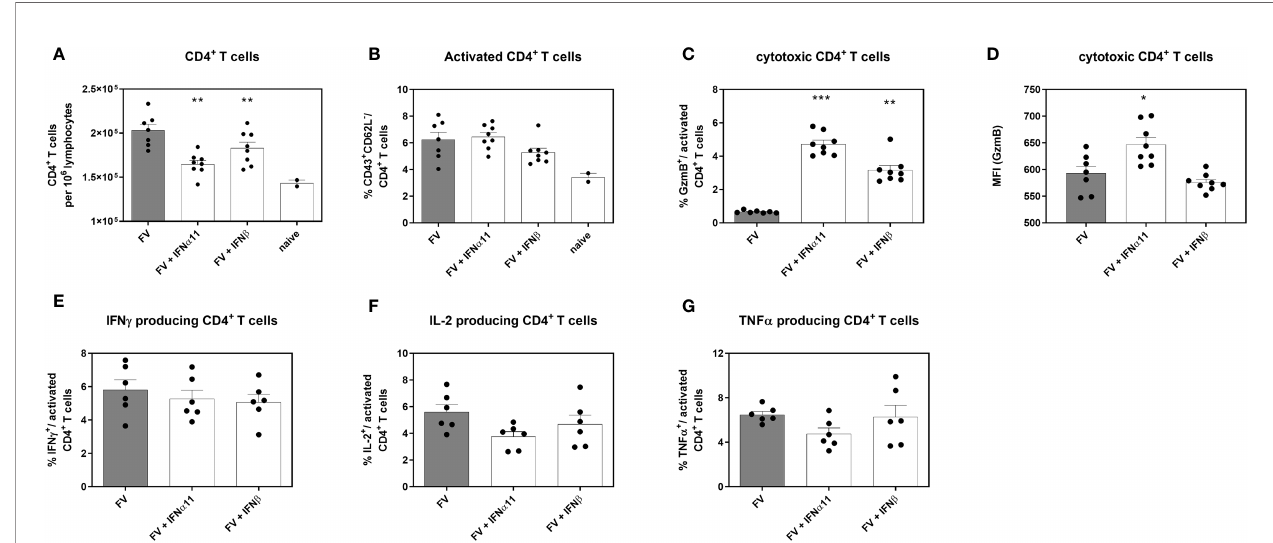
FIGURE 4 | Analysis of intracellular cytotoxic molecules and cytokine expression of CD4 + T cells in type I IFN-treated chronically FV-infected mice. C57BL/6 mice were infected with 20,000 SFFU of FV and additional 100,000 FFU of F-MuLV. Mice were treated daily with 8000 units of IFN a 11 or IFN b from day 40 to 44 mice. At day 45 post infection, mice were sacri fi ced and CD4 + T cell effector functions were analyzed by fl ow cytometry. Numbers of CD4 + T cells (A) , percentages of CD43 + CD62L - activated CD4 + T cells (B) , percentages of intracellular expression determine of (C) GzmB and (D) individual GzmB expression (MFI) was determined. Multi- parametric fl ow cytometry was used to measure percentages of intracellular expression of IFN g (E) , IL-2 (F) and TNF a (G) in activated CD4 + T cells. Mean values (+SEM) are indicated by bars. Statistically signi fi cant differences between the IFN-treated groups and the untreated group were analyzed using Kruskal-Wallis one- way analysis and Dunn ’ s multiple comparison and are indicated by * for p < 0.05; ** for p < 0.01; *** for p <